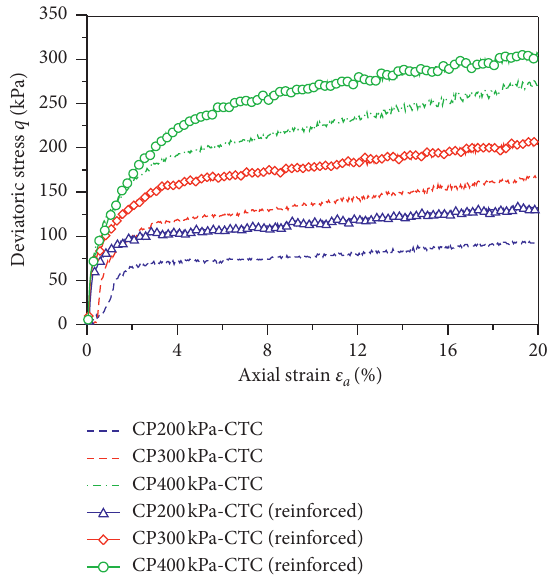
Figure 3: Undrained stress-strain relation of Lantian loess and reinforced Lantian loess under the CTC stress